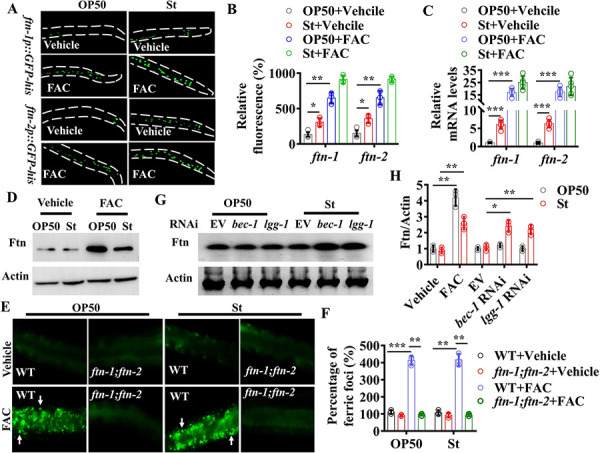
Autophagy promotes degradation of ferritin.(A) Expression of ftn-1p::gfp-his and ftn-2p::gfp-his was upregulated in worms infected with S. Typhimurium (St) or treated with ferric ammonium citrate (FAC, 100 μM) for 12 h. The dotted lines were used to outline the intestine. (B) Fluorescence intensity of ftn-1p::gfp-his and ftn-2p::gfp-his. These results are mean ± SD of three independent experiments performed in triplicate. (n = 30 worms per experiment). *P < 0.05; **P < 0.01. Underlying data are available in S2 Table. (C) The mRNA levels of ftn-1 and ftn-2. These results are mean ± SD of five independent experiments. ***P< 0.001; ns, not significant. Underlying data are available in S2 Table. (D) The protein levels of ferritin in worms exposed to S. Typhimurium or E. coli OP50 in the absence or presence of FAC. The blots are typical of three independent experiments. (E) Representative images of the ferric foci labelled by RDN3, a ferric (Fe3+)-selective fluorescent sensor, in worms exposed to S. Typhimurium or E. coli OP50 for 24 h in the absence (upper panels) or presence (lower panels) of FAC. The arrows denote representative ferric foci. (F) Percentage of ferric foci. These results are mean ± SD of three independent experiments. (n = 20 worms per experiment). ***P< 0.001; **P < 0.01. Underlying data are available in S2 Table. (G) The protein levels of ferritin in worms subjected to bec-1 or lgg-1 RNAi or empty vector (EV) after S. Typhimurium infection. The blots are typical of three independent experiments. (H) Quantification of ferritin protein levels from Western blot (D and G). These results are mean ± SD of three experiments. *P< 0.05; **P< 0.01. p-Values throughout were calculated using a one-way ANOVA followed by a Student-Newman-Keuls test. Underlying data are available in S2 Table.